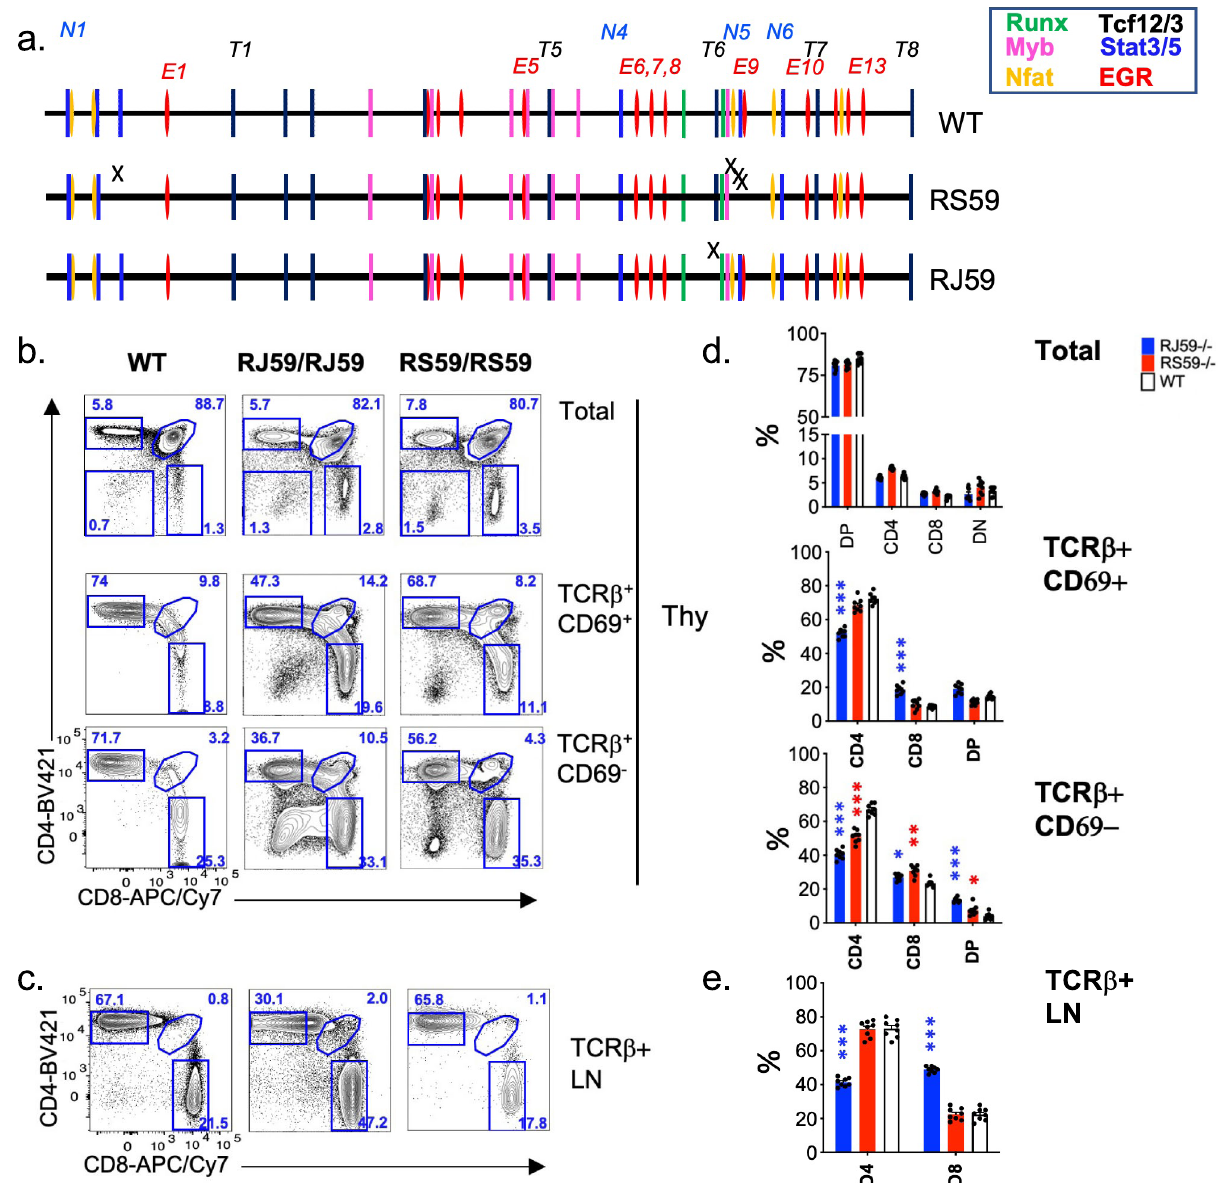
Fig. 9 Mutation of HEB/E2A binding motifs adjacent to conserved Runx sites enhances Sil ThPOK function. a Position of TF consensus binding sites for wt silencer, or indicated mutant RJ59 and RS59 alleles. FACS analysis of TCR β , CD69, CD4, and CD8 expression of ( b ) total thymocytes, gated thymocytes and ( c ) peripheral T-cell subsets of wt mice or mutant lines, as indicated. d , e Plots showing % of DP, SP CD4, SP CD8, and DN thymocytes for mice of indicated genotypes. N = 6 independent animals per strain. Data are presented as mean values + / − SEM. A P value < 0.05 was considered signi fi cant. Statistical signi fi cance was determined between mice of ThPOK SIL.CD4Rx/SIL.CD4Rx and ThPOK + / + genotypes by one-way ANOVA with post hoc Tukey HSD, and indicated by asterisks (* P < 0.01; ** P < 0.005; *** P < 0.001). Statistical signi fi cance was calculated for each indicated mutant line